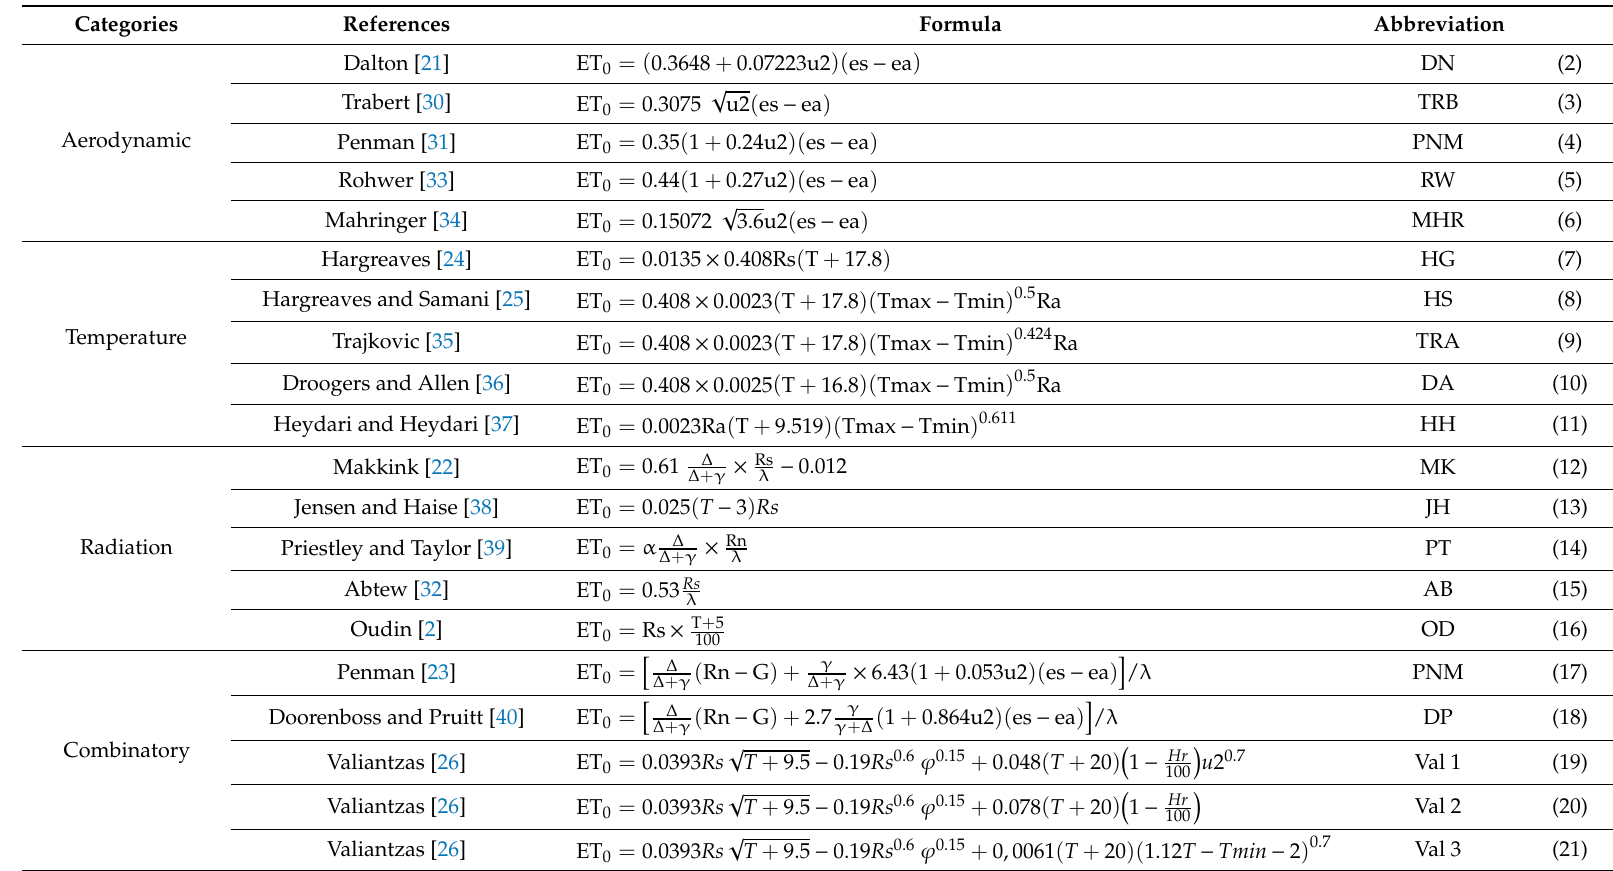
Table 2. Characteristics of the 20 alternative methods